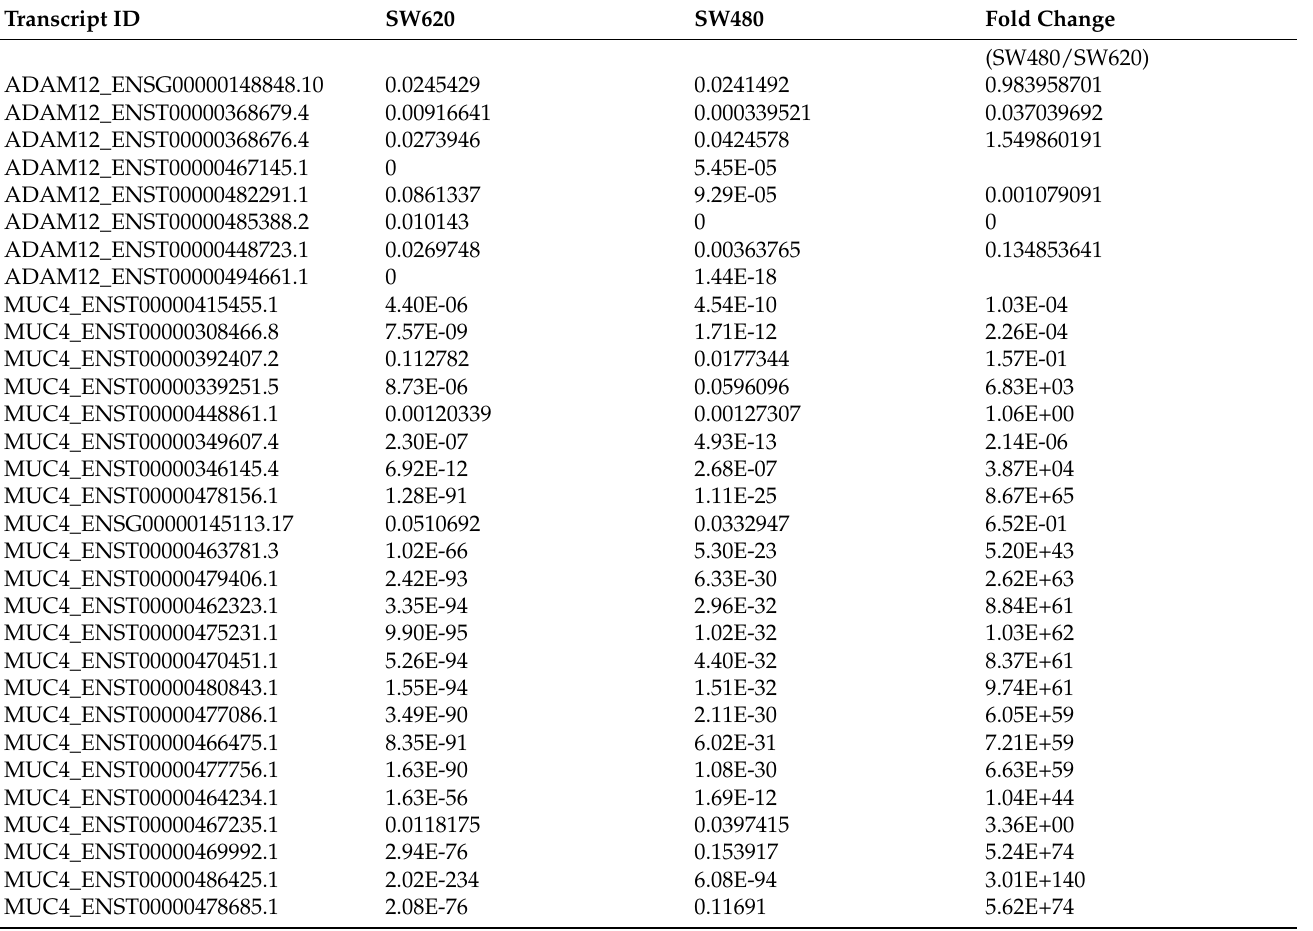
Table 2. FPKM values for ADAM12 and MUC4 transcripts obtained from RNA-Seq